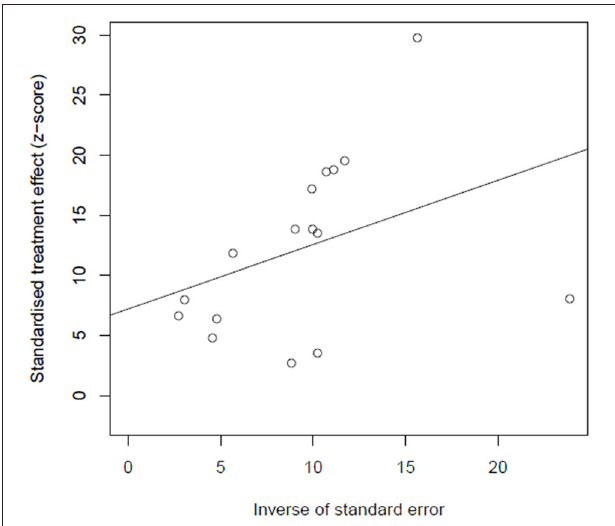
FIGURE 6 | Funnel plot of publication